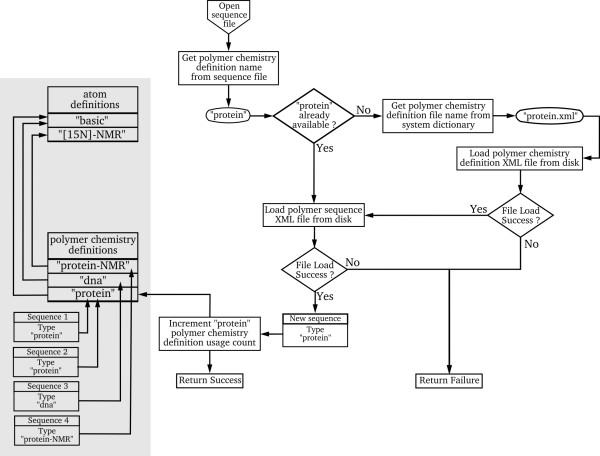
Each polymer sequence has a connection with a polymer chemistry definiton. It is crucial, for the proper functioning of the software, that each polymer sequence be permanently connected to a valid polymer chemistry definition. This is required so that the biochemical/mass spectrometric simulations be performed using proper chemical entities. This figure illustrates the algorithm which is used in the software to make sure that any polymer sequence being loaded in the sequence editor has a corresponding polymer chemistry definition associated to it and that this definition is actually available on the system.